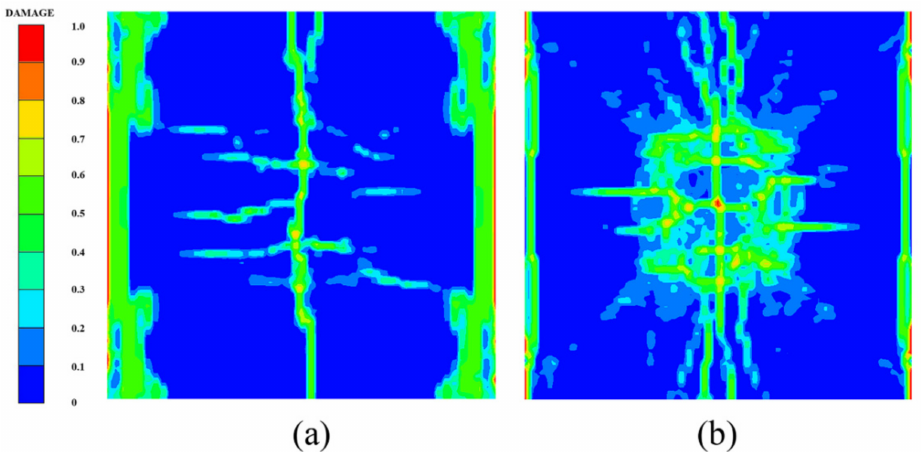
Figure 14. Numerical results of the CEL model: ( a ) top surface; ( b ) bottom surface.